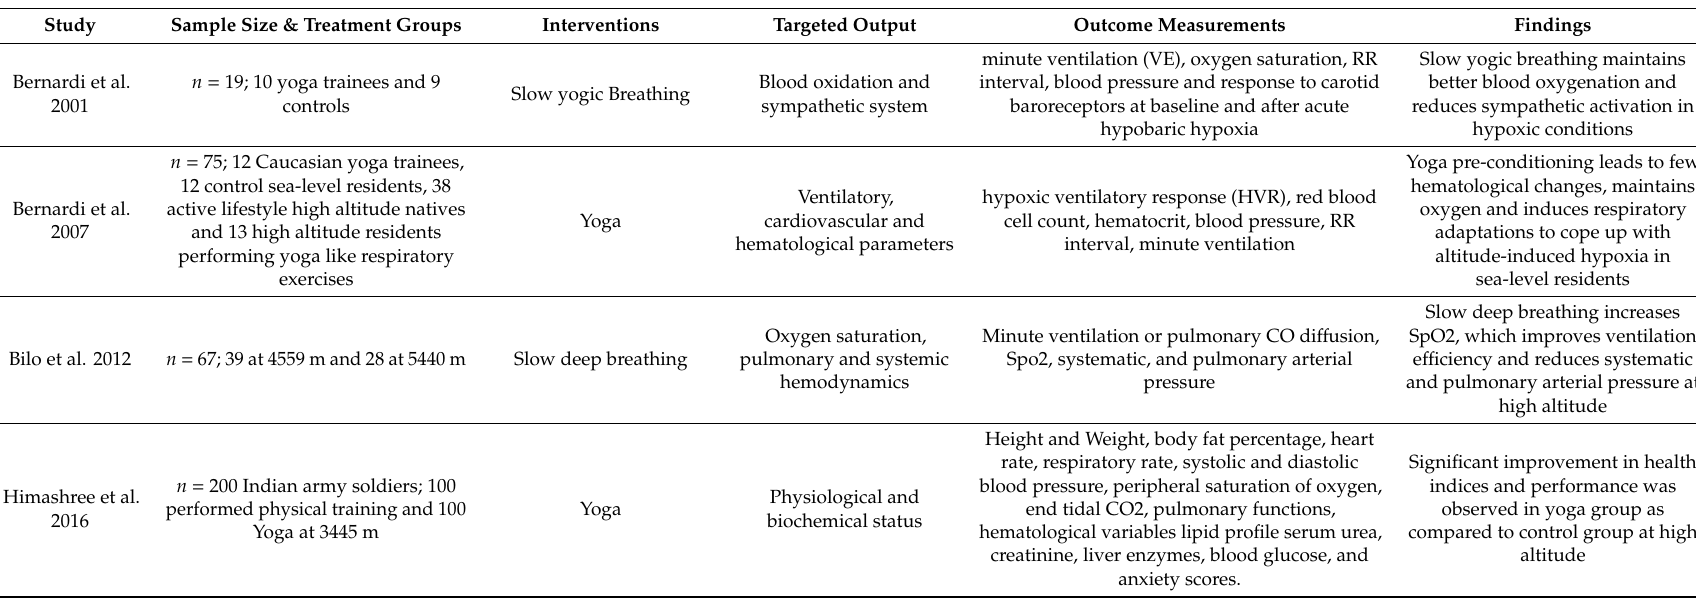
Table 2. Studies showing the impact of